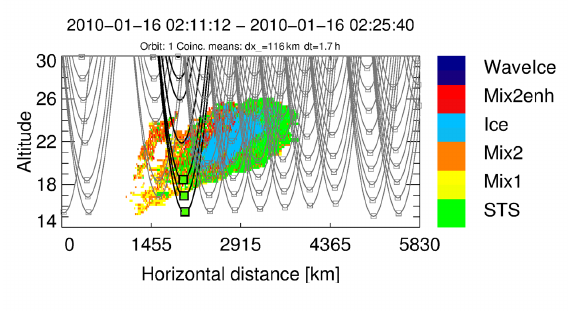
Figure 14. Visualization of the MIPAS limb paths (black lines) and a coincident MIPAS profile (coloured black-framed squares; other profiles do not fulfil the coincidence criteria) compared to the CALIOP high-resolution nadir measurements of PSC types (coloured pixels). The colour bar refers to the CALIOP PSC type classification. For details see